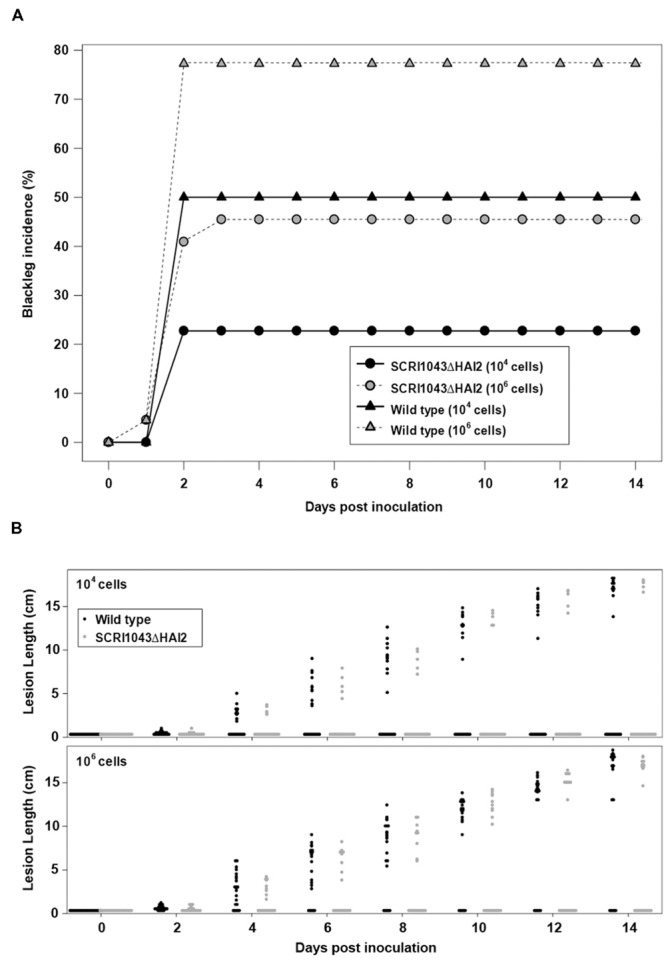
Deletion of HAI2 from Pectobacterium atrosepticum SCRI1043 reduces development of blackleg on potato stems. (A) Incidence of blackleg (% of plants with stem lesions) at each assessment for plants inoculated with either SCRI1043ΔHAI2 or the wild type. Each bacterium was inoculated into plants at either 104 or 106 cells per inoculation site. (B) Dot-histograms of lesion lengths on stems for each of 22 potato plants inoculated with either 104 or 106 cells per inoculation site of SCRI1043ΔHAI2 or the wild type. Measurements were taken every second day to 14 days post-inoculation.